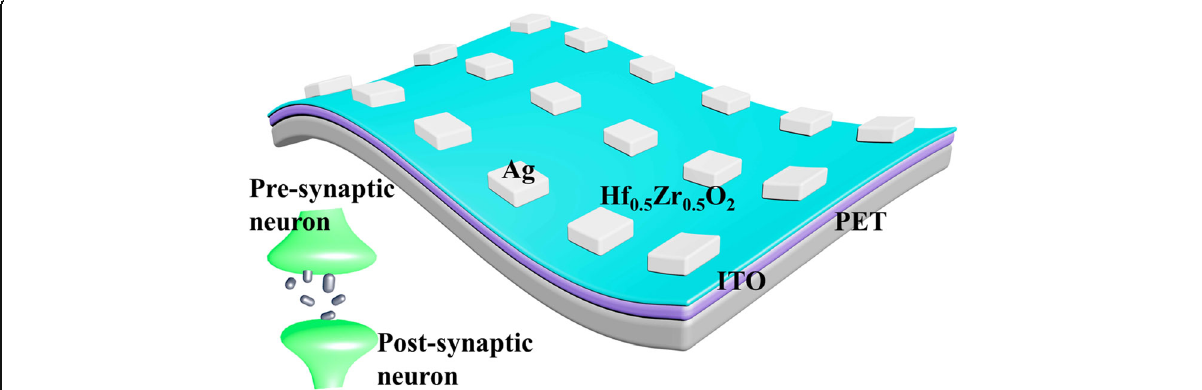
Fig. 1 Schematic illustration of biological synapse between neurons and artificial electrical synapses. A bio-synapse was composed of pre-synaptic neuron, synaptic cleft, and post-synaptic neuron. The HZO-based flexible electrical synapse was fabricated with the structure of ITO/HZO/Ag on the plastic substrate at low temperature